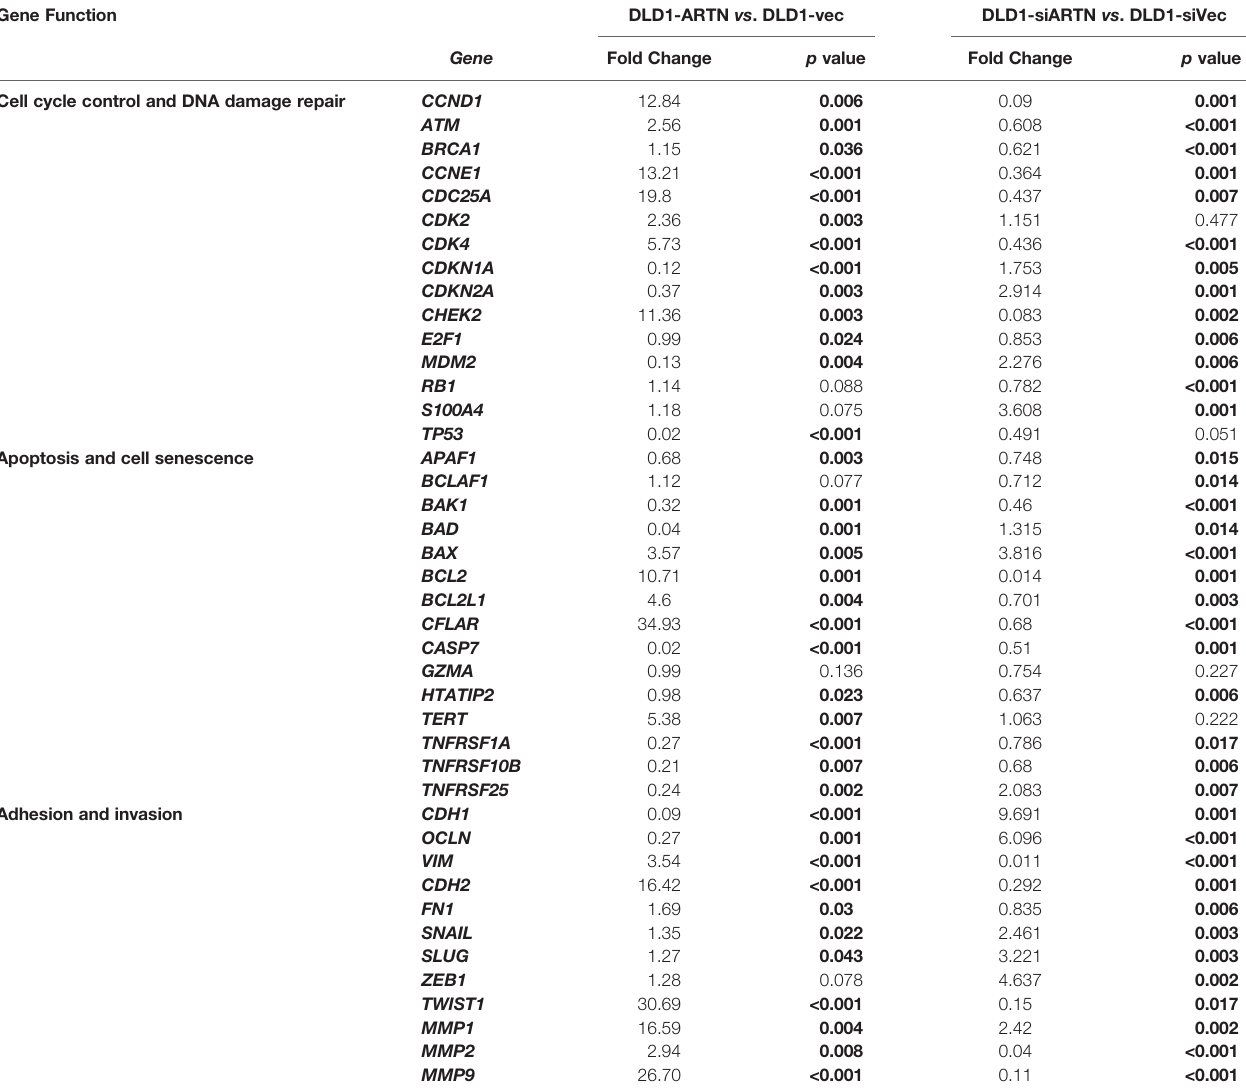
TABLE 3 | Real-time PCR for the mRNA expression of genes in DLD1 cell lines with either forced or depleted expression of ARTN. Gene